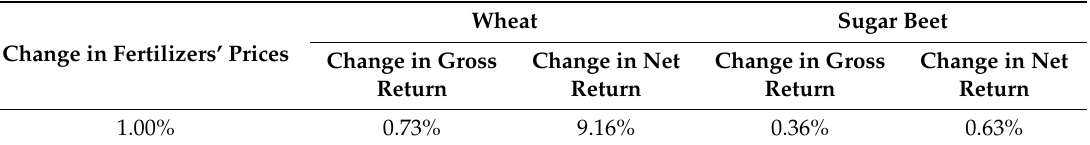
Table 5. The impact of the percentage change of the fertilizers’ prices on the percentage change in the gross return and net return in wheat and sugar beet